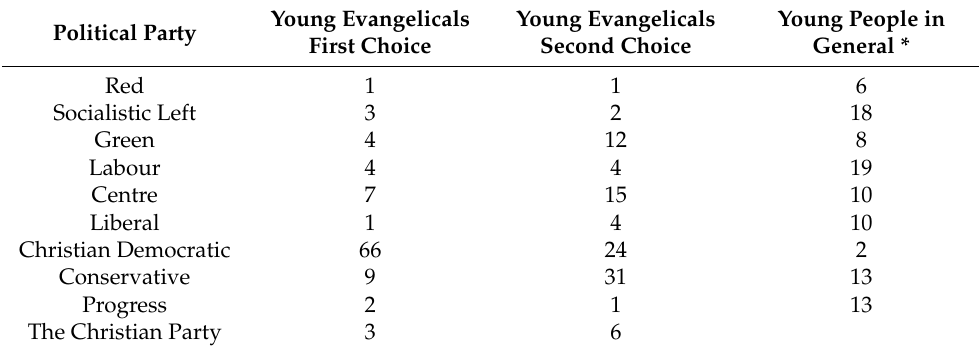
Table 4. Affiliation with a political party. Young evangelicals and young people in Norway in general, percent.